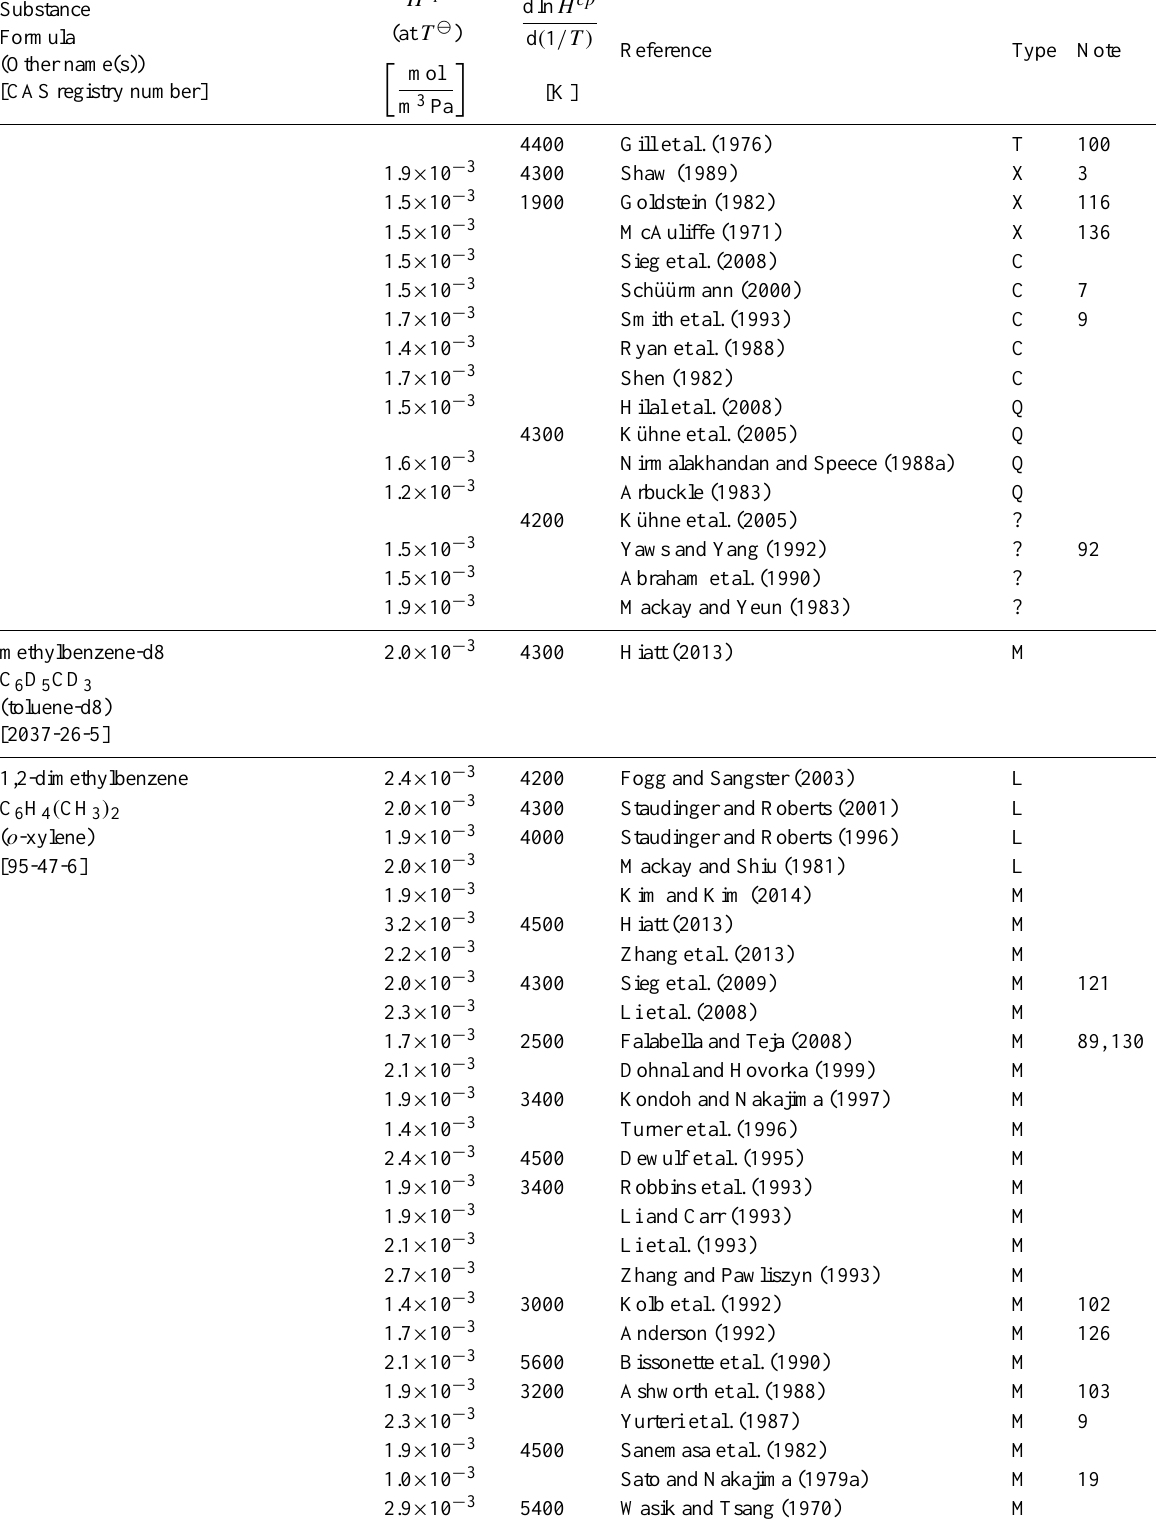
Table 6: Henry’s law constants for water as solvent